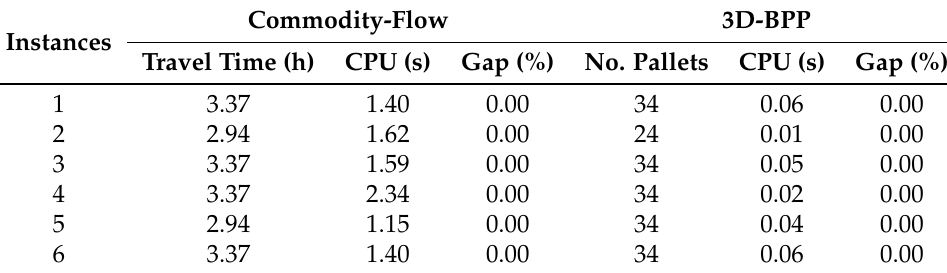
Table 2. Experimental results for real and symmetric